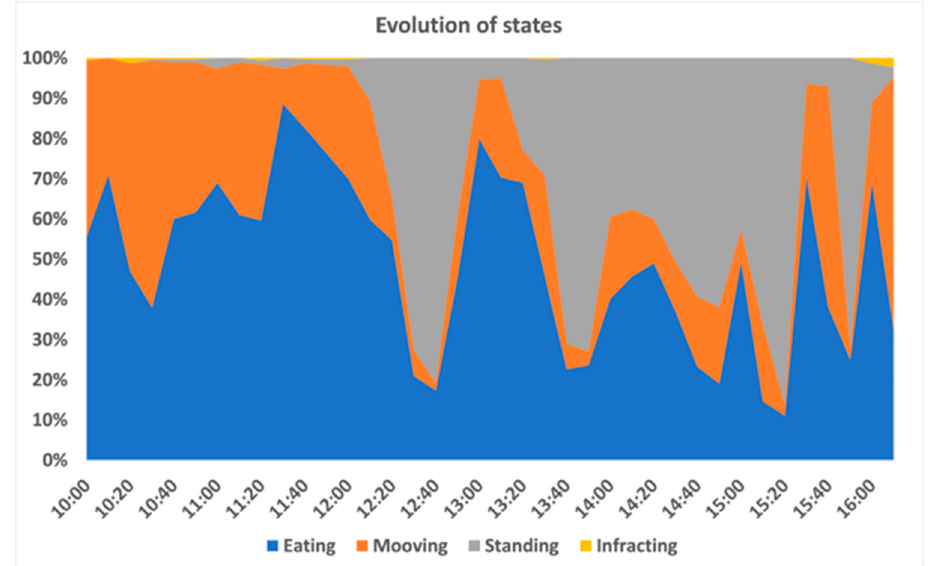
Figure 11. Collar M states evolution.